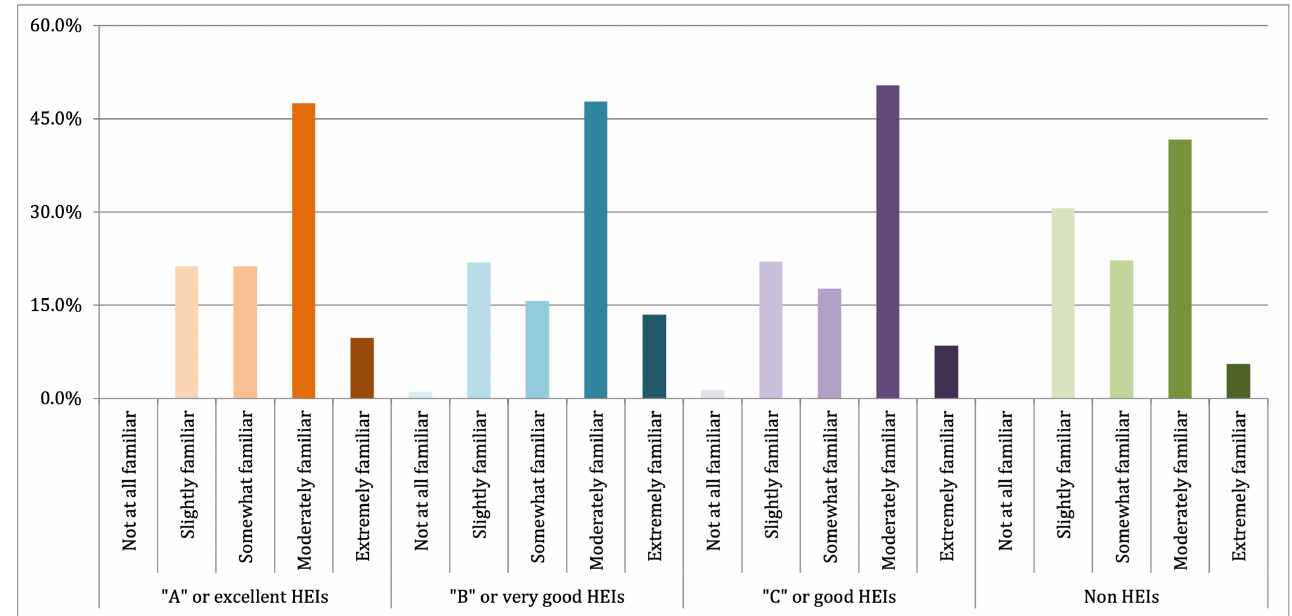
Figure 7. Indonesian scientists’ perceptions of their level of knowledge of institutions’ policies or procedures regarding research data governance.